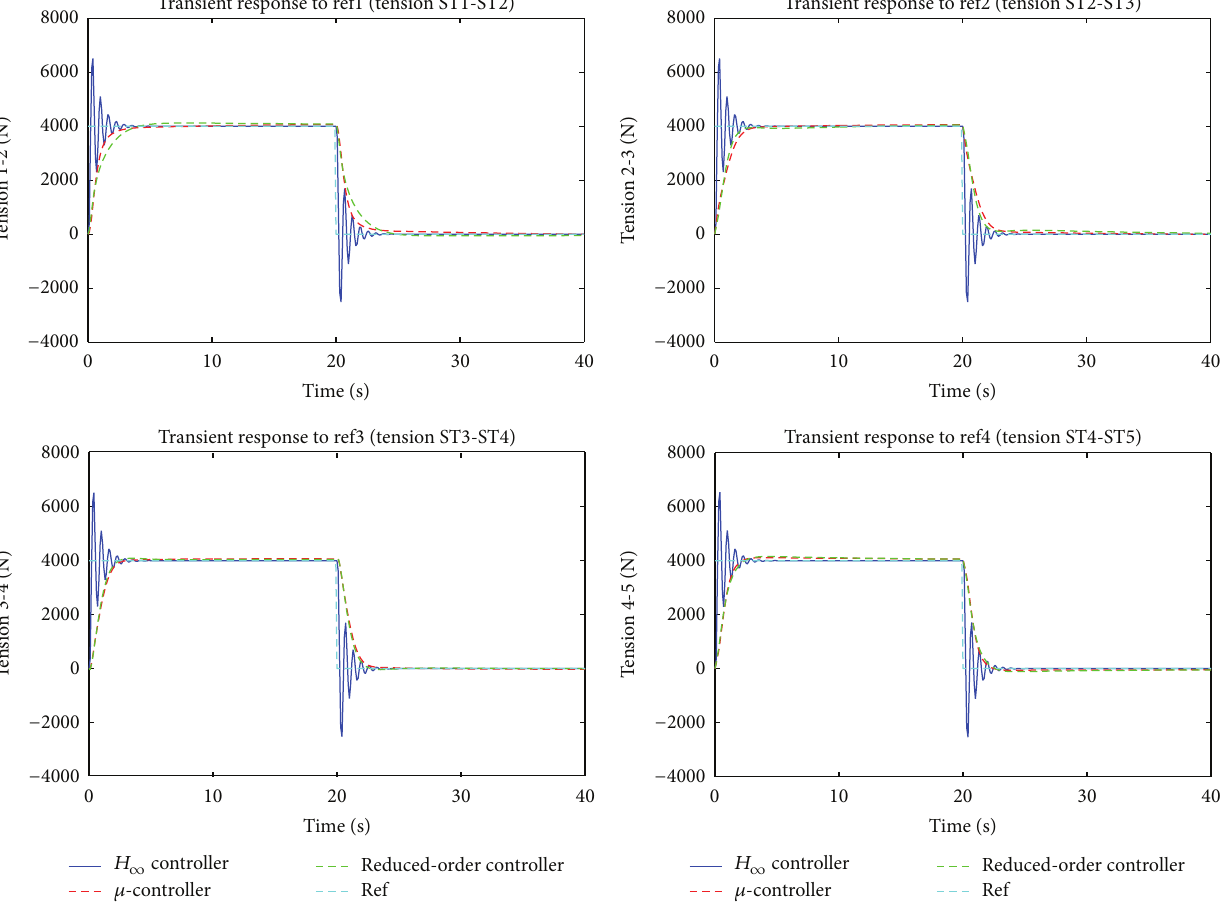
Figure 16: Comparison of transient response to reference